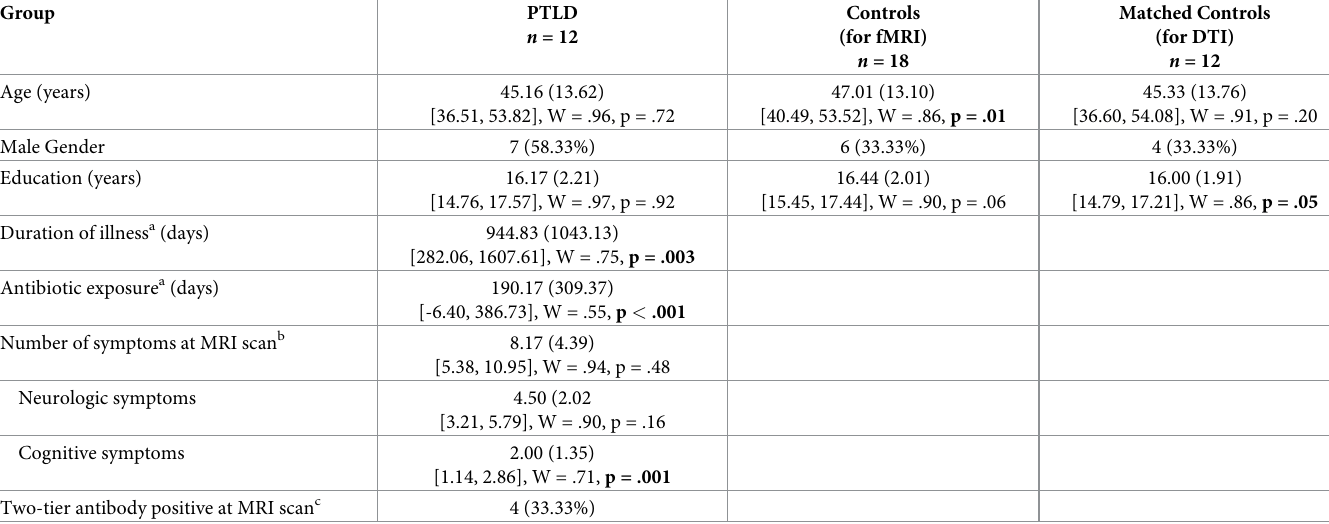
Table 1. Baseline demographic and clinical characteristics. N (%) are presented for categorical variable; mean (standard deviation), 95% confidence interval [lower limit, upper limit] are presented for continuous variables; Shapiro-Wilk tests were used for tests of normality. Significant values of the Shapiro-Wilk tests are denoted in bold, p � .05, two-tailed. Control groups did not differ from PTLD for age, education, or